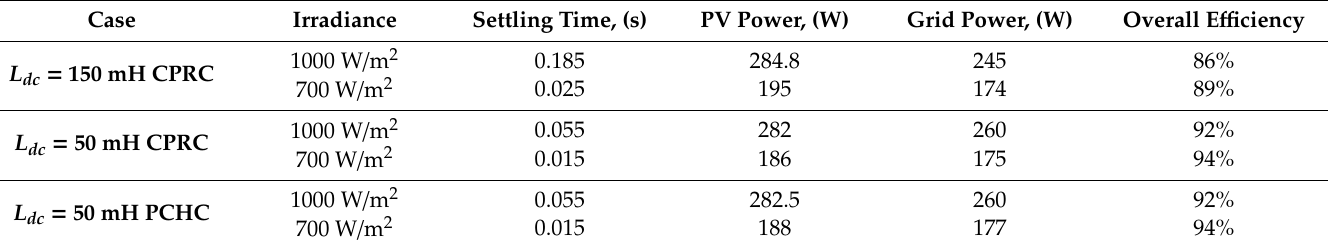
Figure 4. Zoom on system performance comparison between CPRC and PCHC under irradiance variation: ( a )–( c ) high power level, ( d )–( f ) low power level. Table 3. Performance parameters of system applied in simulation work.